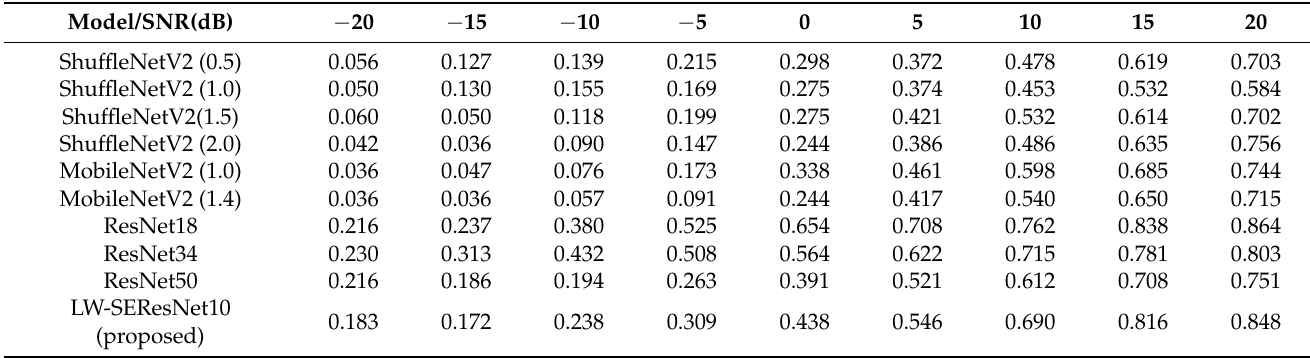
Table 9. The F1-score of multiple models under different